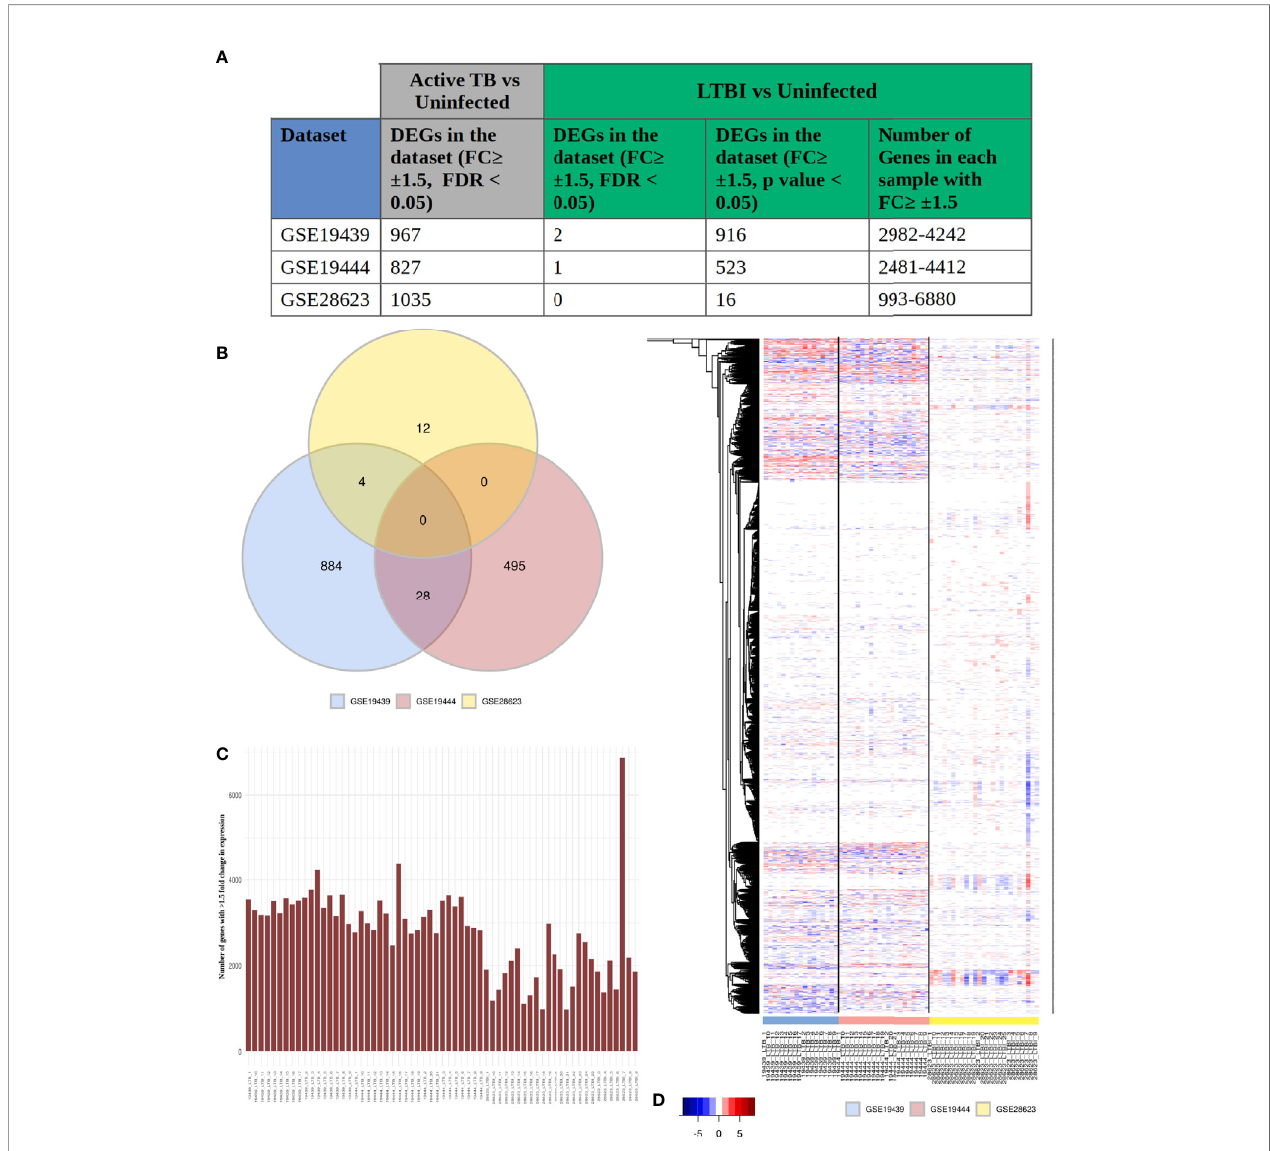
FIGURE 1 | LTBI patients have a highly heterogeneous gene expression pro fi le. (A) The three selected datasets GSE19439, GSE19444 and GSE28623 showed a signi fi cant number of genes to be differentially regulated in active TB condition but very few DEGs in LTBI when compared to uninfected cases with conventional thresholds of FDR ≤ 0.05 and fold change ≥ ± 1.5 criteria. More number of genes could be considered as DEGs if the criteria are modi fi ed to unadjusted p value ≤ 0.05 and fold change ≥ ± 1.5. However each of these samples contained thousands of genes with ≥ ± 1.5 fold change in gene expression compared to uninfected individuals. (B) Venn diagram shows that there are no common DEGs in LTBI condition (unadjusted p value ≤ 0.05, fold change ≥ ± 1.5) between all three datasets. The number of common DEGs between any two datasets are also very few. (C) Each LTBI sample contained over 1000 genes with ≥ ± 1.5 fold change, showing a signi fi cant difference between the gene expression pro fi le of the individual samples from uninfected cases. (D) Heatmap shows the fold change of expression of the genes in each individual LTBI sample that showed ( ≥ ± 1.5) fold change in any sample (union of all genes from Figure 1A , column 5). White signi fi es no signi fi cant fold change ( ≤ ± 1.5), red stands of upregulation in gene expression and blue shows downregulation. It is clear that although all the samples show signi fi cant change in the gene expression pro fi les, it is not consistent across the samples, suggesting a heterogeneous response to LTBI in